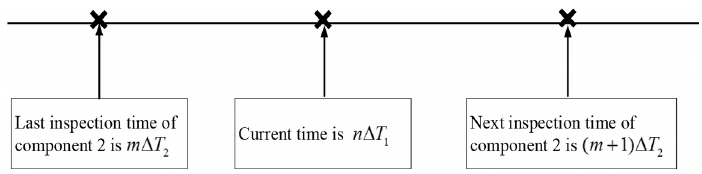
Figure 3. Sketch of inspection time